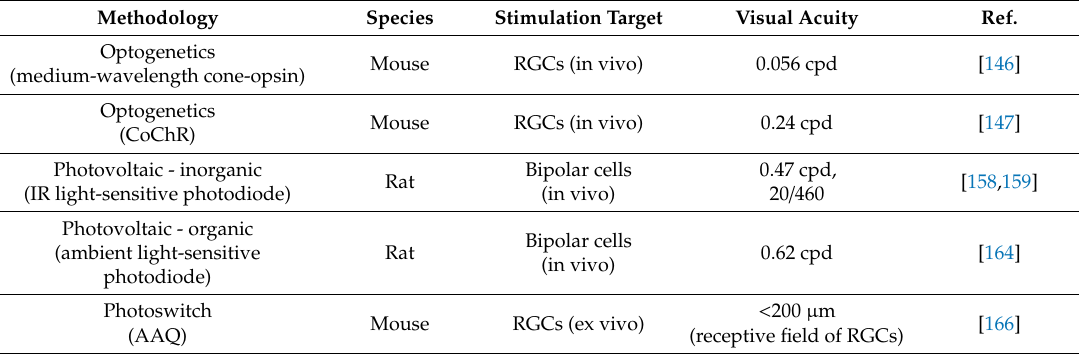
Table 2. Optical stimulation (OS)-based retinal prostheses and their visual